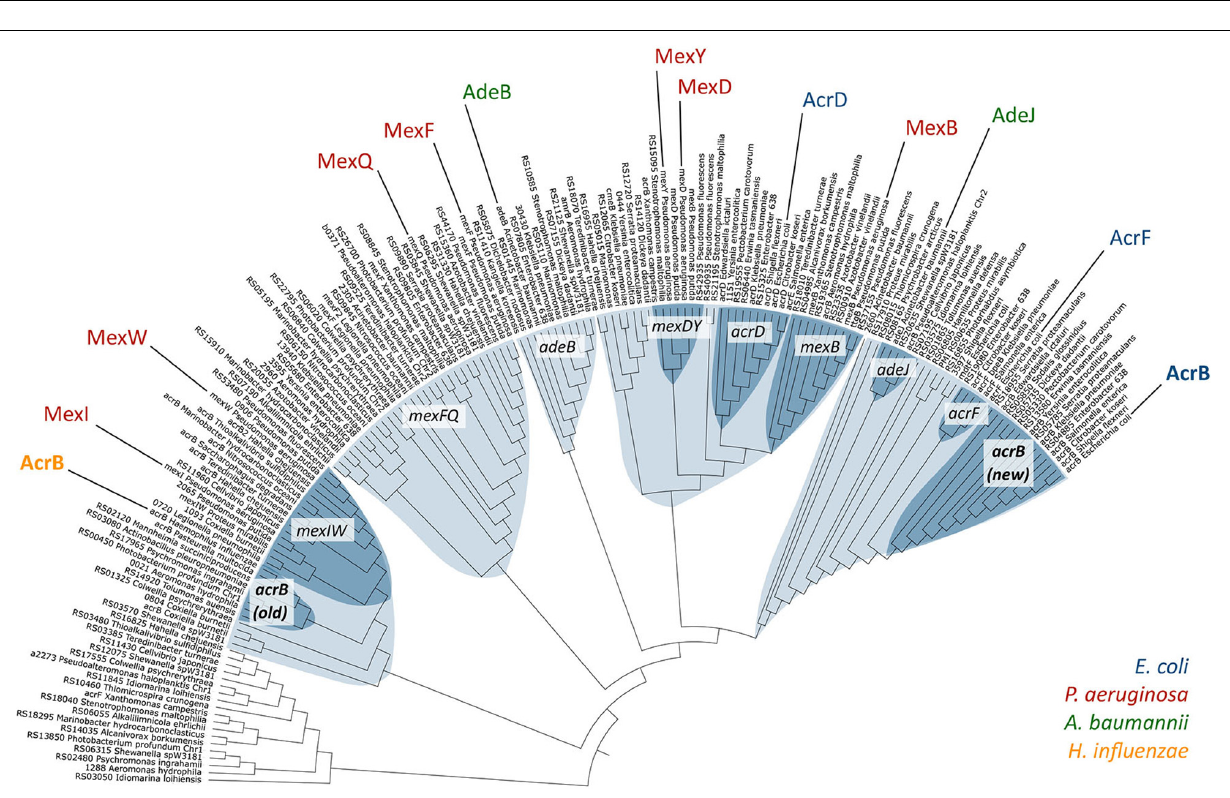
FIGURE 9 | Phylogenetic relationships among a selection of RND-type MDR transporters. Different clusters are shown in light blue, and sub-clusters in dark blue. AcrB-Hi ( H. influenzae ) is on the left in yellow, and AcrB-Ec ( E. coli ) on the far right in blue (Zwama et al.,